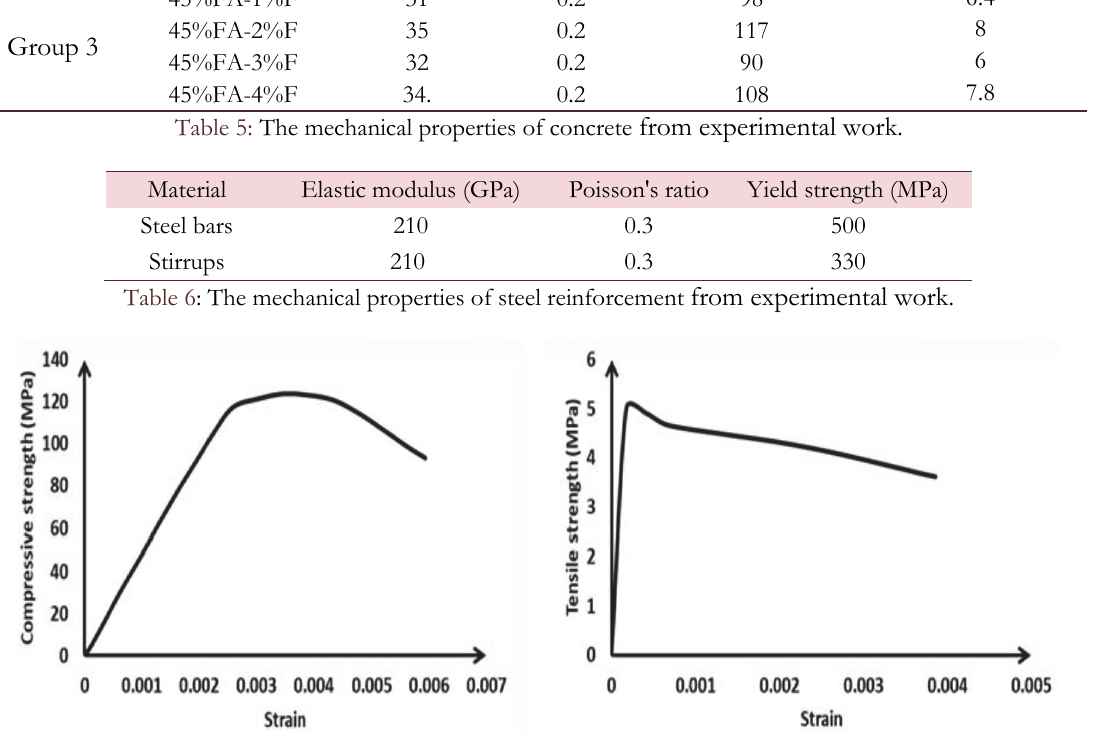
Figure 15: The stress-strain response of G-UHPFRC